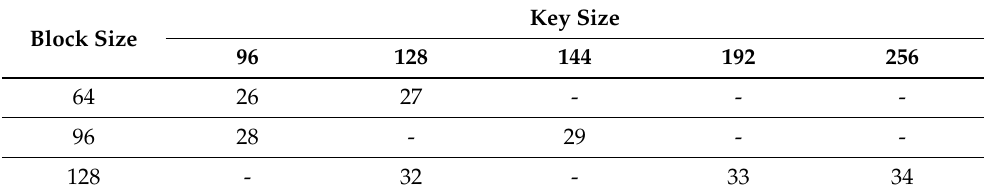
Table 1. Rounds of different block size.